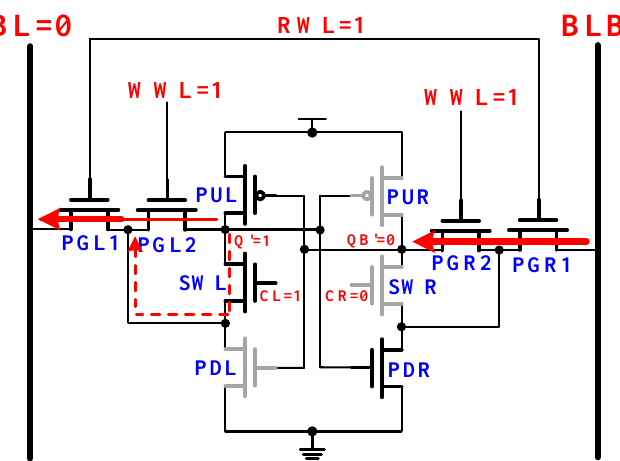
Figure 3. The write operation of proposed 10T SRAM cell.